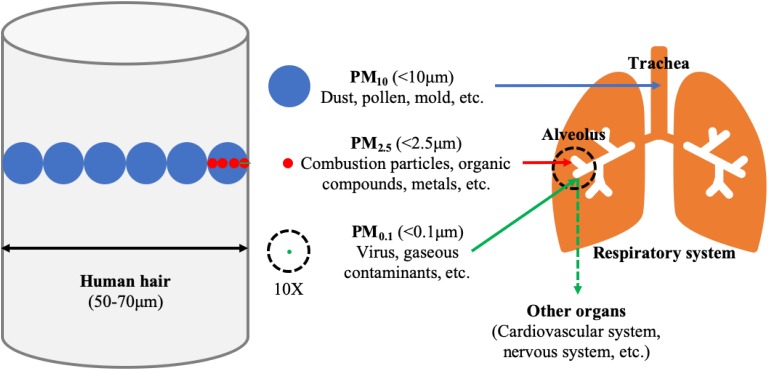
The size, main composition and deposition site in the lung of the particulate matter (PM). The average diameter of human hair is 60 μm, which approximately equivalents to six inhalable particulate matter (PM10, <10 μm in diameter, blue color), or twenty-four fine particulate matter (PM2.5, <2.5 μm in diameter, red color) or six hundred ultrafine particulate matter (PM0.1, <0.1 μm in diameter, green color). Particulate matter, with aerodynamic diameter 2.5–10 μm, is mainly deposited on the trachea. PM less than 2.5 μm in diameter poses the greatest problems, because it can get deep into the terminal bronchioles and alveoli, and some with <0.1 μm in diameter may even get into the bloodstream affecting other organs. 10X: The stuff in the dotted ring is magnified ten times.